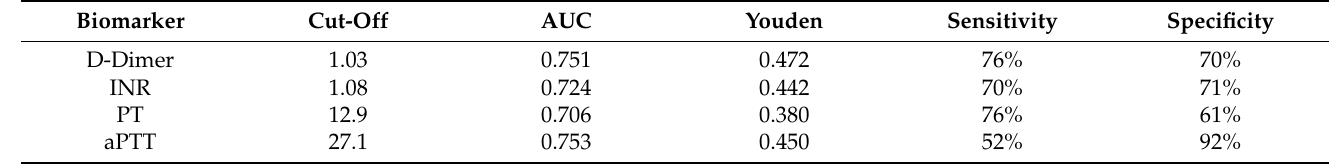
Table 2. AUC-ROC of coagulation biomarkers and optimal